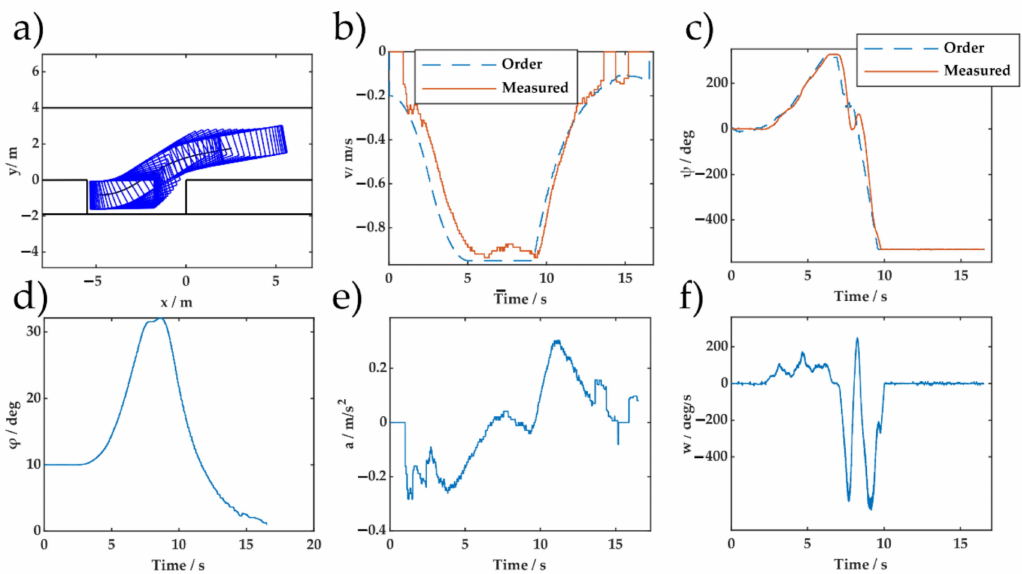
Figure 16. Experimental parking control and state profiles of DERL for the initial pose (2.5 m, 1.75 m, 10 ◦ ): ( a ) Parking trajectory; ( b ) speed profile; ( c ) steering wheel angle profile; ( d ) orientation angle; ( e ) acceleration; and ( f ) steering wheel